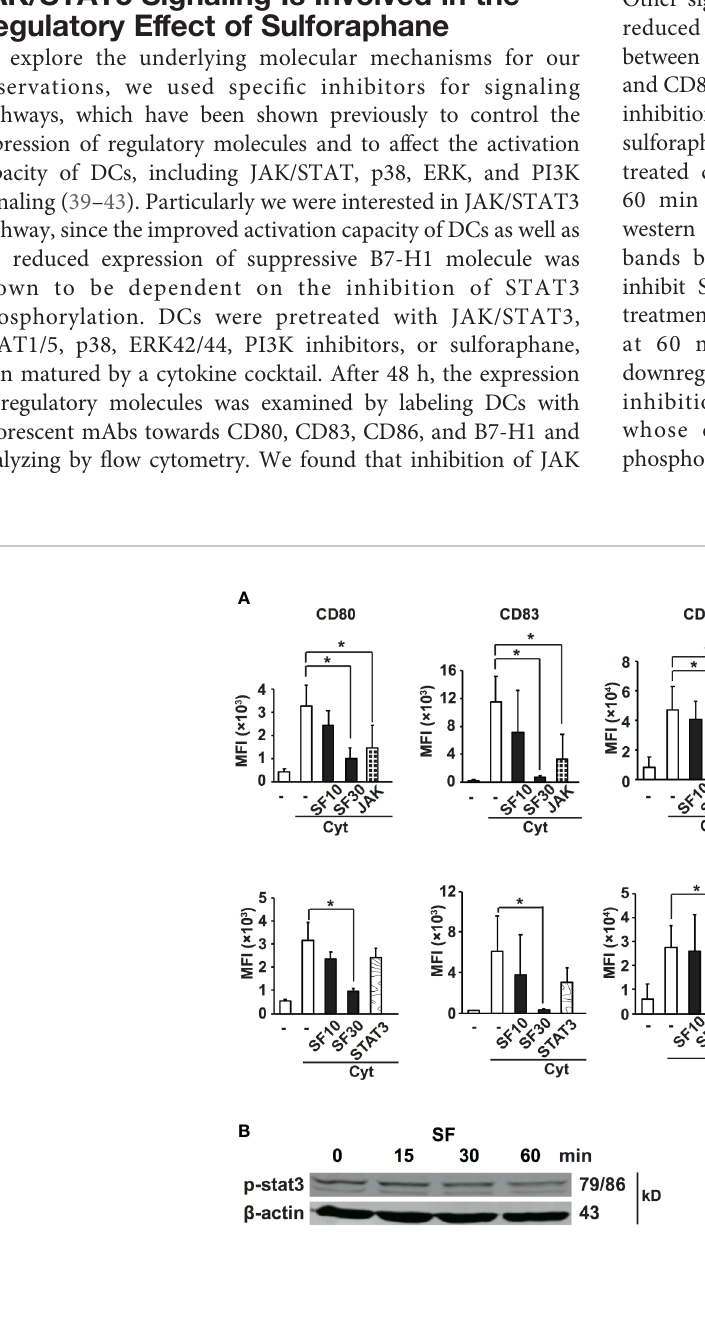
FIGURE 3 | Sulforaphane-reduced phosphorylation of STAT3 leads to the downregulation of B7-H1. (A) Monocyte-derived dendritic cells (MoDCs) were pretreated with vehicle control, indicated concentrations of sulforaphane (SF) or respective pathway inhibitors for 30 min. Then cytokine cocktail (Cyt) or vehicle control was added into the cultures. Cells were collected 48 h later, labeled with B7-H1-PE, CD80-FITC, CD83-APC, or CD86-PE antibody and analyzed by fl ow cytometry and FlowJo software. Data are presented in Mean fl uorescence intensity (MFI) ± SD, *P ≤ 0.05, n = 4-7. (B) MoDCs were treated with sulforaphane or vehicle control for 15 min, 30 min and 60 min, activated by cytokine cocktail, the proteins were harvested and phosphorylation of STAT3 was examined by western blot. The expression of b -actin served as a control for equal total protein. The band intensities (pixel intensities) were evaluated using ImageJ software after normalization to b -actin, n = 3, *P ≤